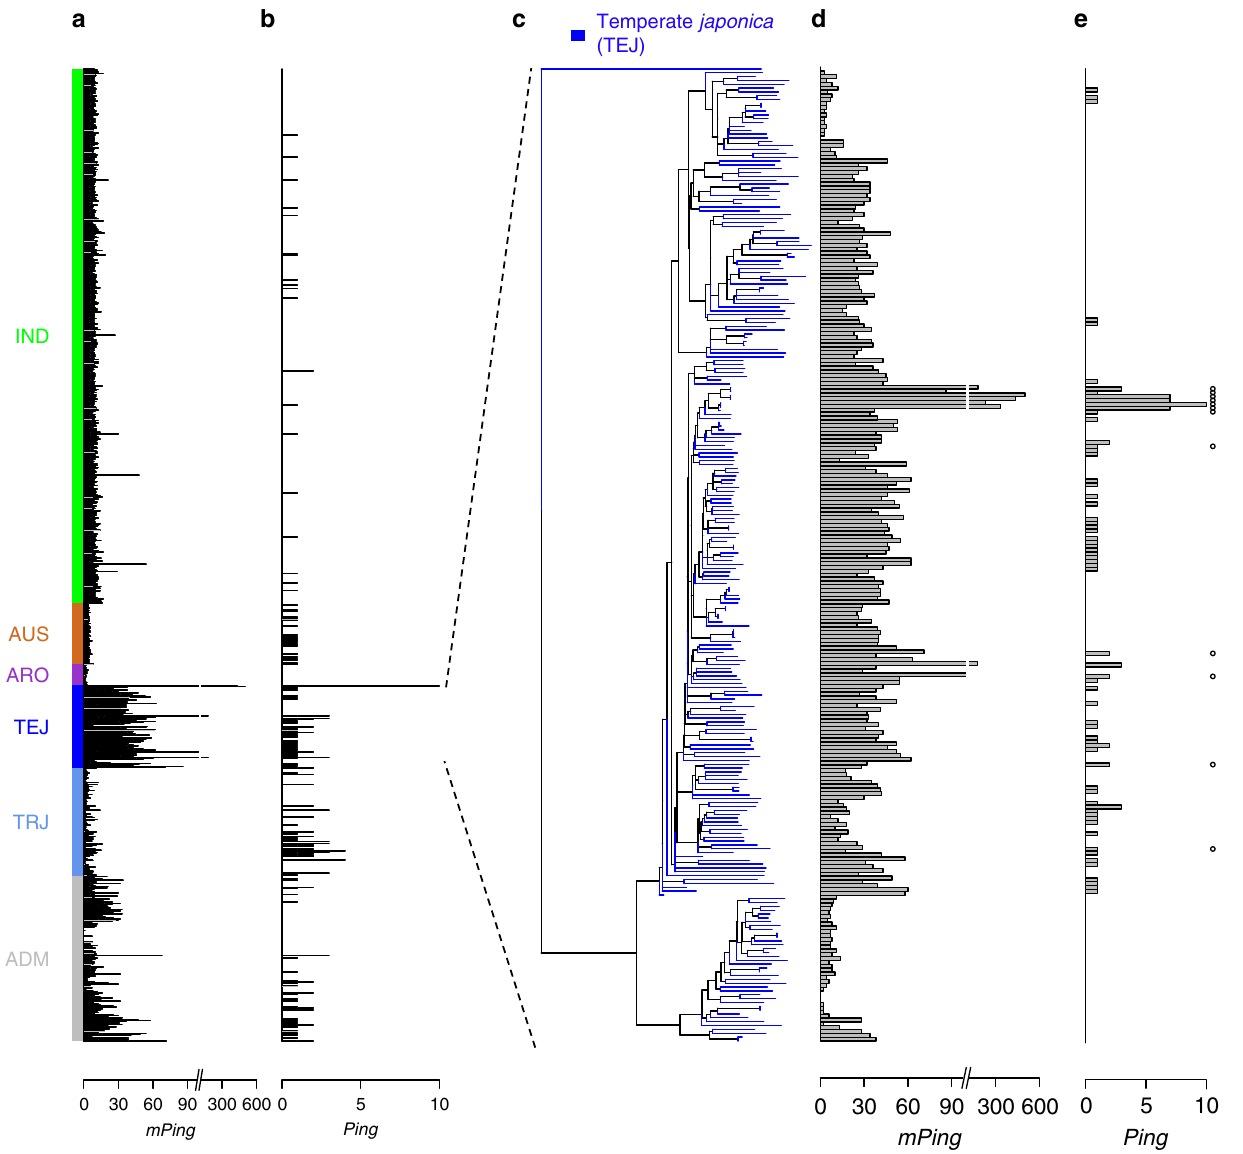
Fig. 2 Copy numbers of mPing, Ping , and Pong elements in rice subgroups. a mPing copy numbers in 3000 genomes and the four accessions undergoing mPing bursts (HEG4, EG4, A119, and A123). Colors represent the fi ve major rice subgroups: indica (IND), aus/boro (AUS), aromatic (ARO), temperate japonica (TEJ), tropical japonica (TRJ), and admixed (ADM). b Ping copy numbers in 3000 genomes and the four accessions undergoing mPing bursts. c Neighbor-joining tree of temperate japonica accessions using genome-wide SNPs. d mPing copy number of temperate japonica accessions. e Ping copy number of temperate japonica accessions. Accessions that have the Ping16A_Stow locus are noted with open circles. Source data for Fig. 2a, b, d, e are provided in Supplementary Data